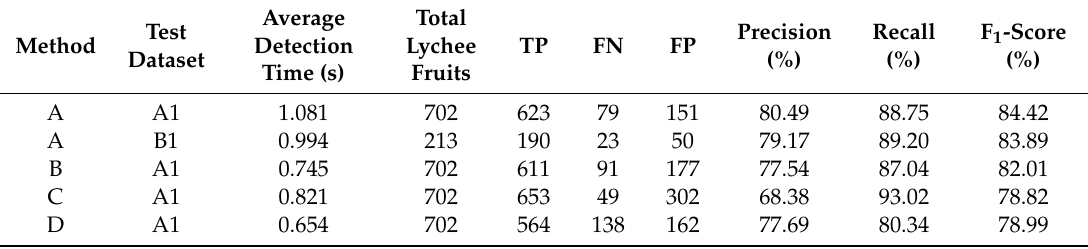
Table 2. Detection results of overlapped lychees under well-illuminated conditions without using the LBP-SVM